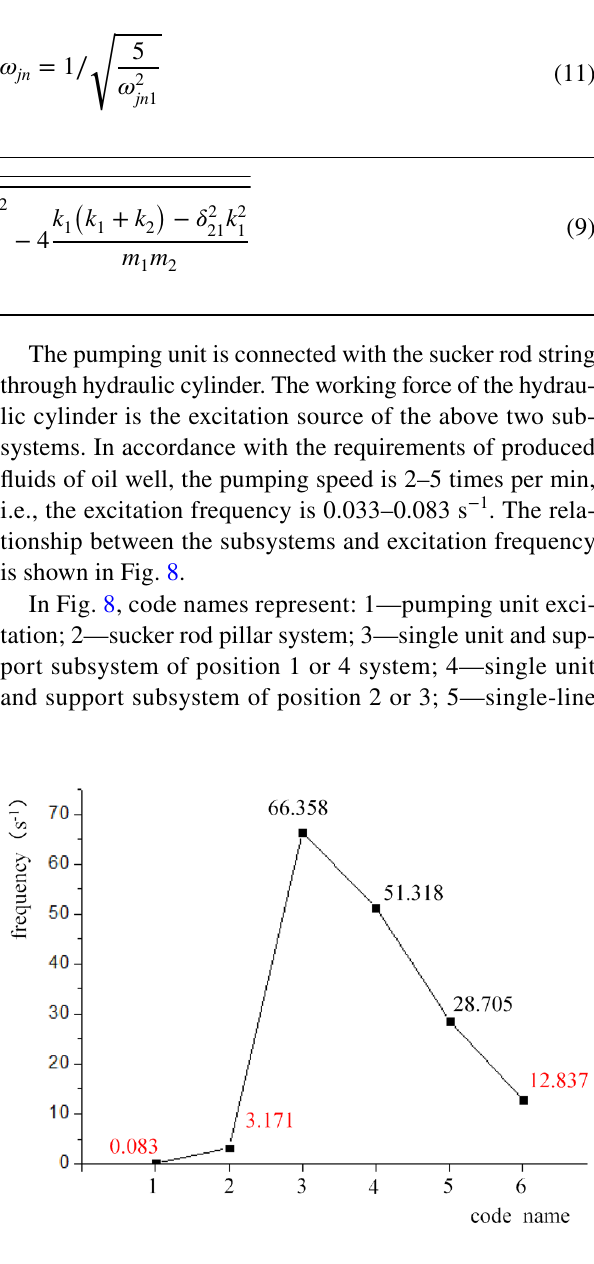
Fig. 8 Relationship between multibody system of LD27-2 WHPB platform and excitation